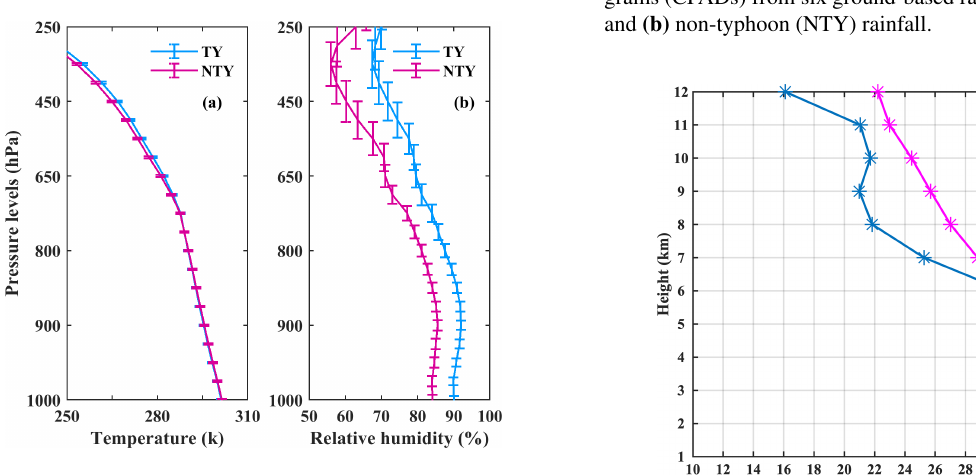
Figure 16. (a) Mean air temperature (degrees Celsius) and (b) rel- ative humidity (percent) profiles for typhoon (TY) and non- typhoon (NTY) rainfall.